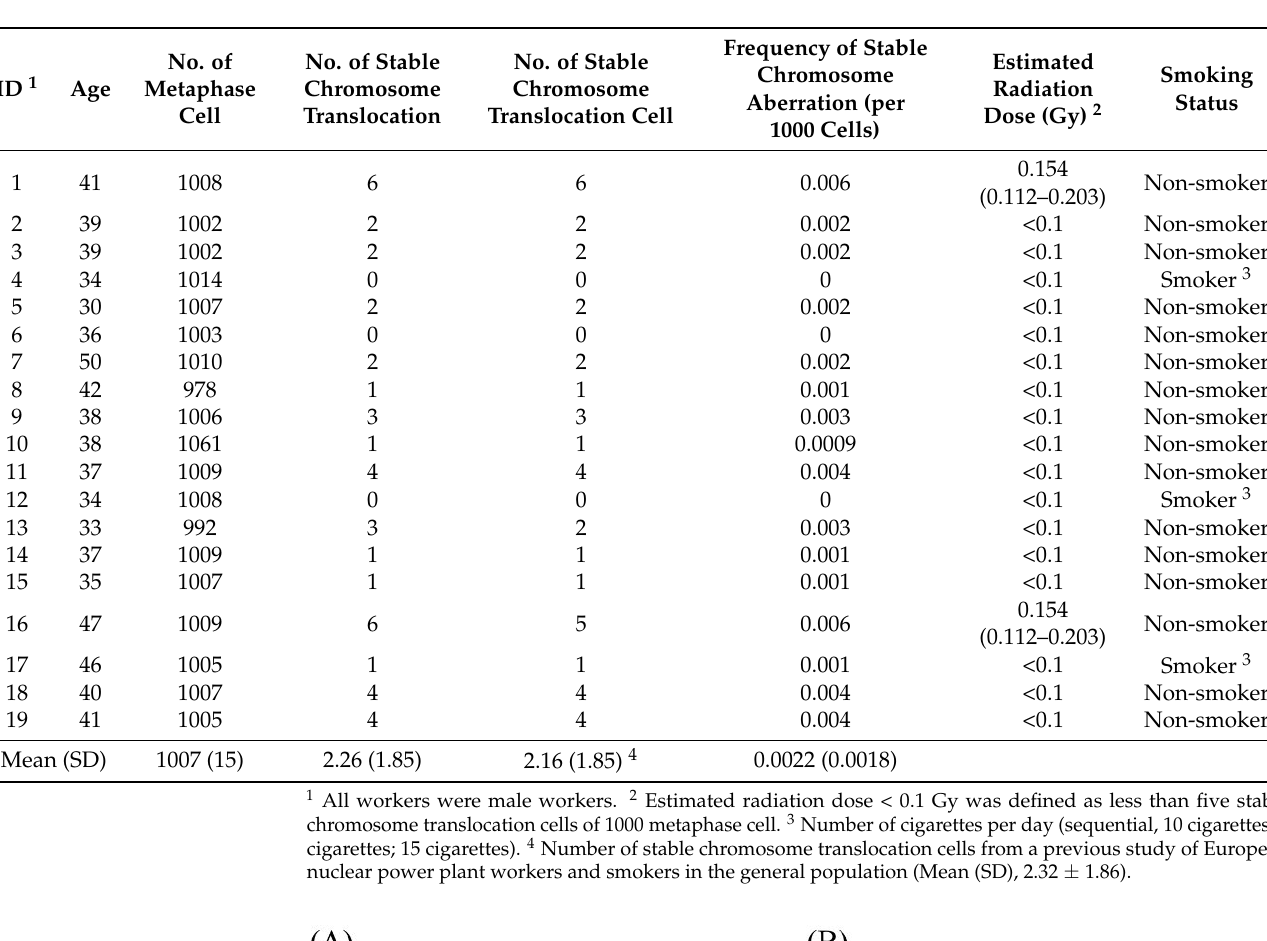
Table 5. Chromosome translocation and estimated exposed dose according to the radiation exposure in semiconductor workers.